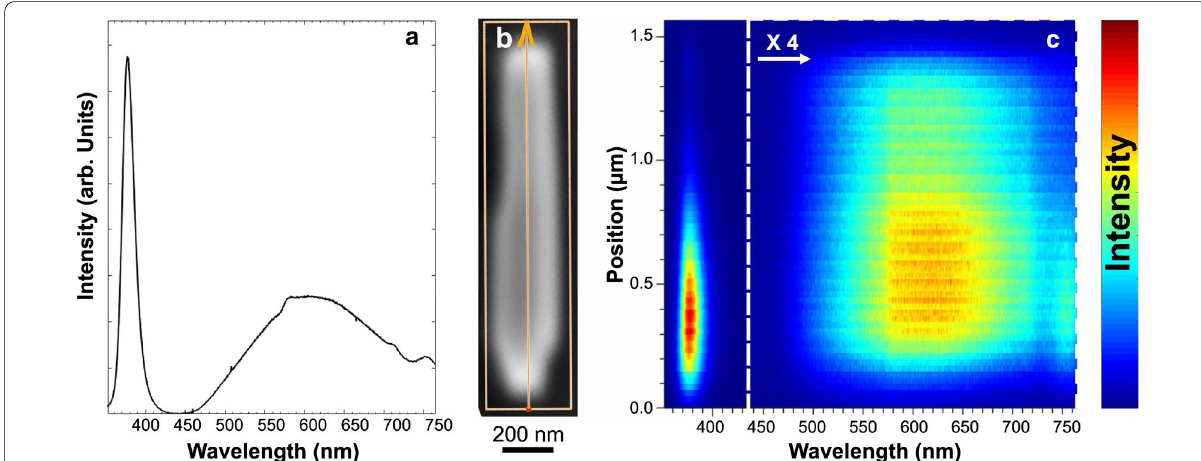
Fig. 7 Cathodoluminescence data from a single ZnO NR transferred to a Si substrate. a A spectrum from the entire NR. b An SEM image of the investigated NR was recorded simultaneously with the luminescence data. The growth direction is along the arrow. c Hyperspectral luminescence map recorded along the line in b . The x-axis is the wavelength, the y-axis in the spatial position and the intensity is plotted in false color scale, as indicated in the figure. Note that the intensity of the defect band around 620 nm is enhanced by a factor of